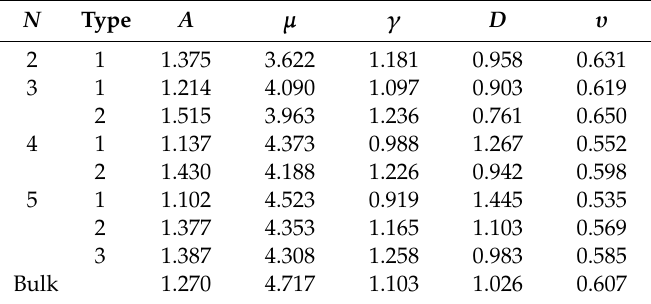
Table 2. Critical parameters of the asymptotic formulas (Equations (1) and (2)) as obtained from non-linear fits on the SAW data presented in Figures 5 and 8 for the confined SC lattice. Also shown for comparison are the results for the bulk (unrestricted) SC.